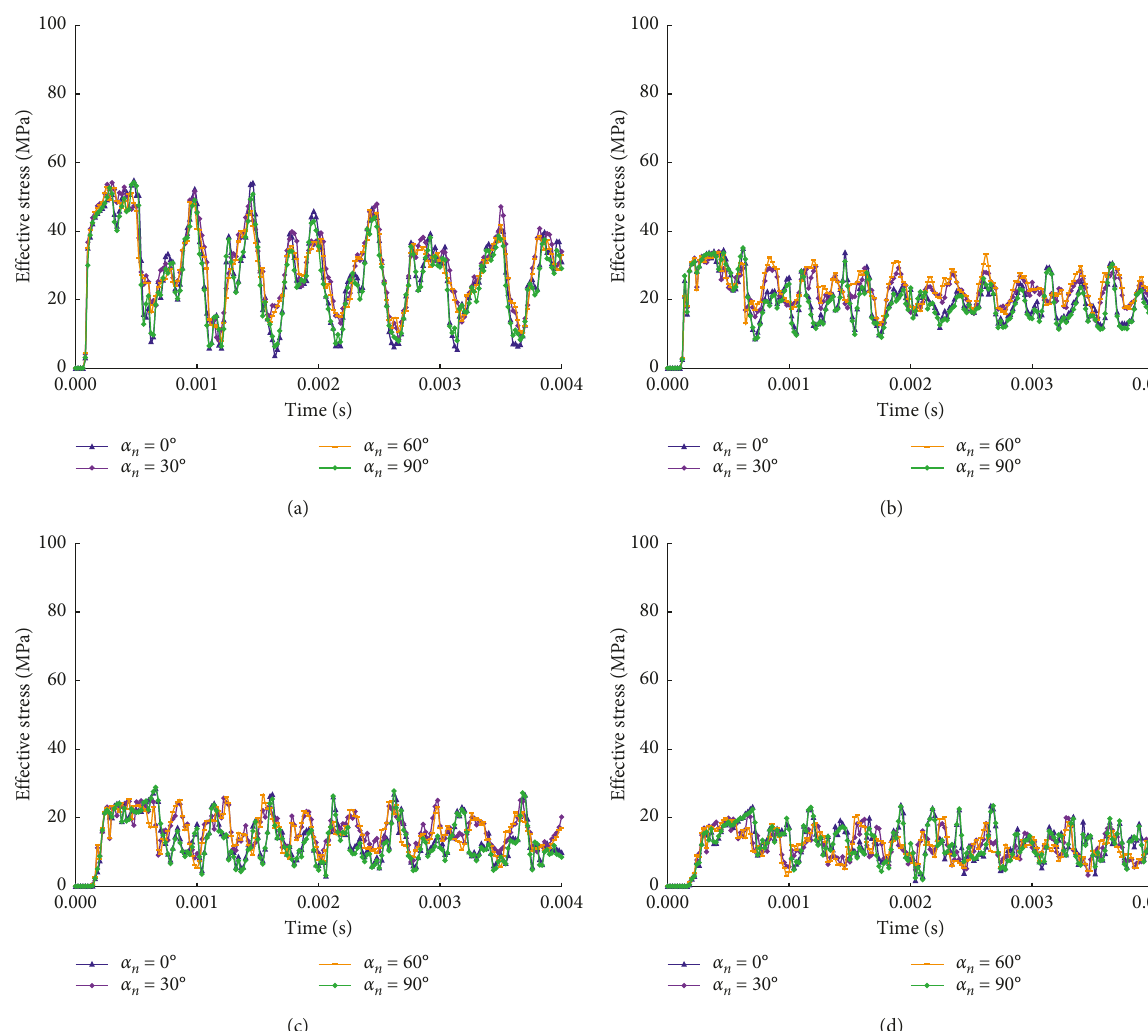
Figure 16: Effective stress curve of different monitoring points of #1 simulation case. (a) D r b �